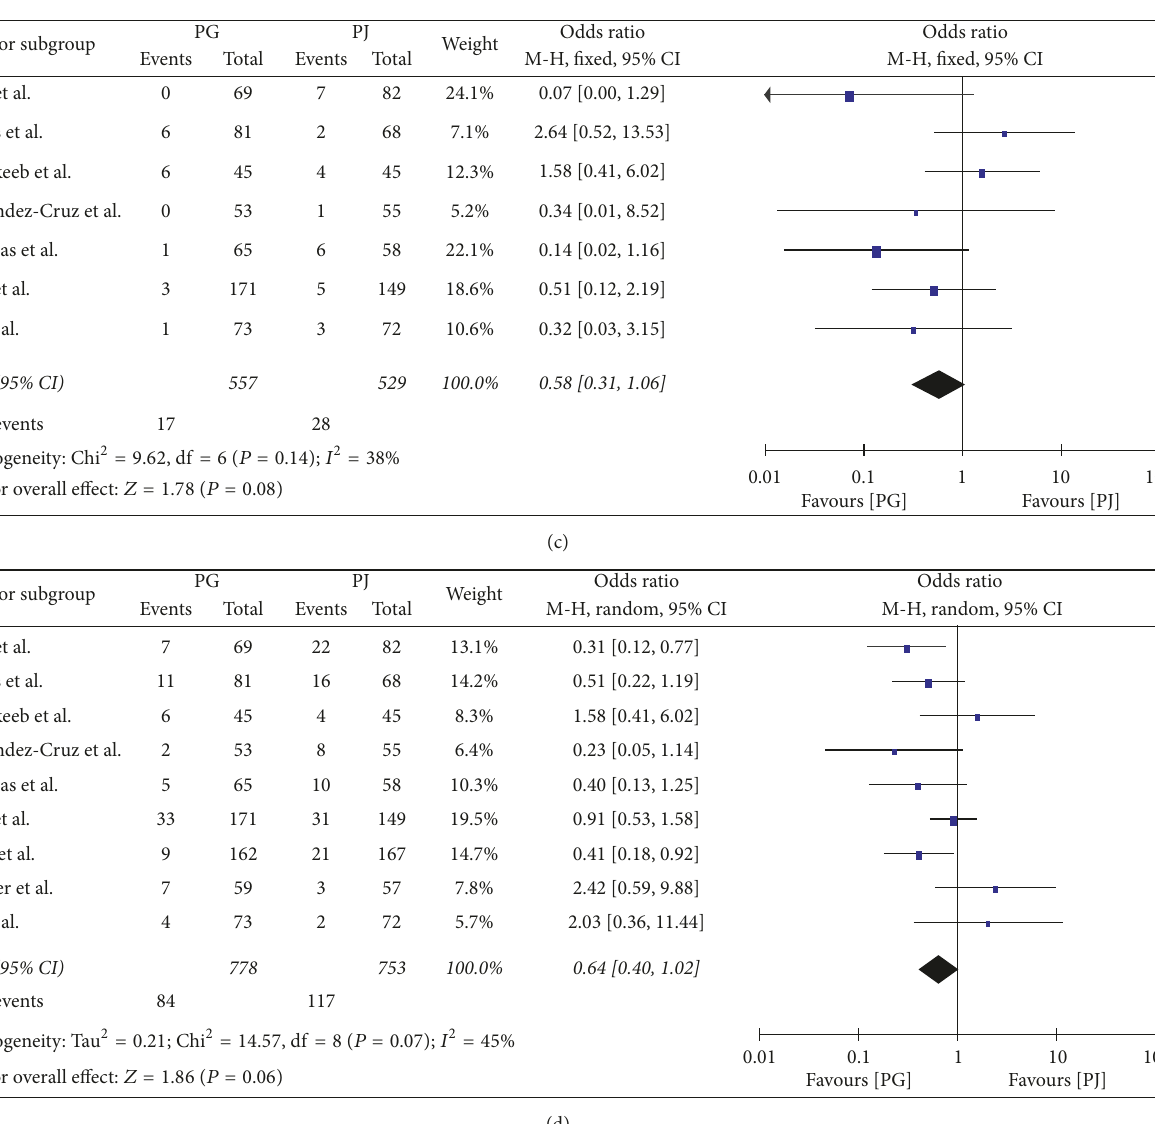
Figure 6: (a) Postpancreatectomy haemorrhage, (b) clinically significant postpancreatectomy haemorrhage, (c) biliary fistula, and (d) intra- abdominal fluid collection.